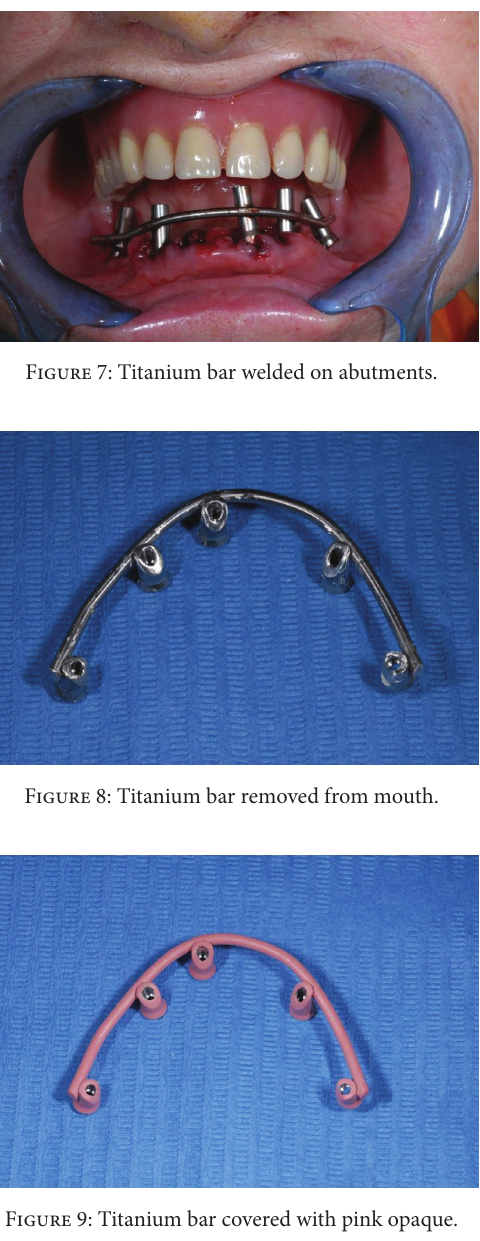
Figure 13: Final